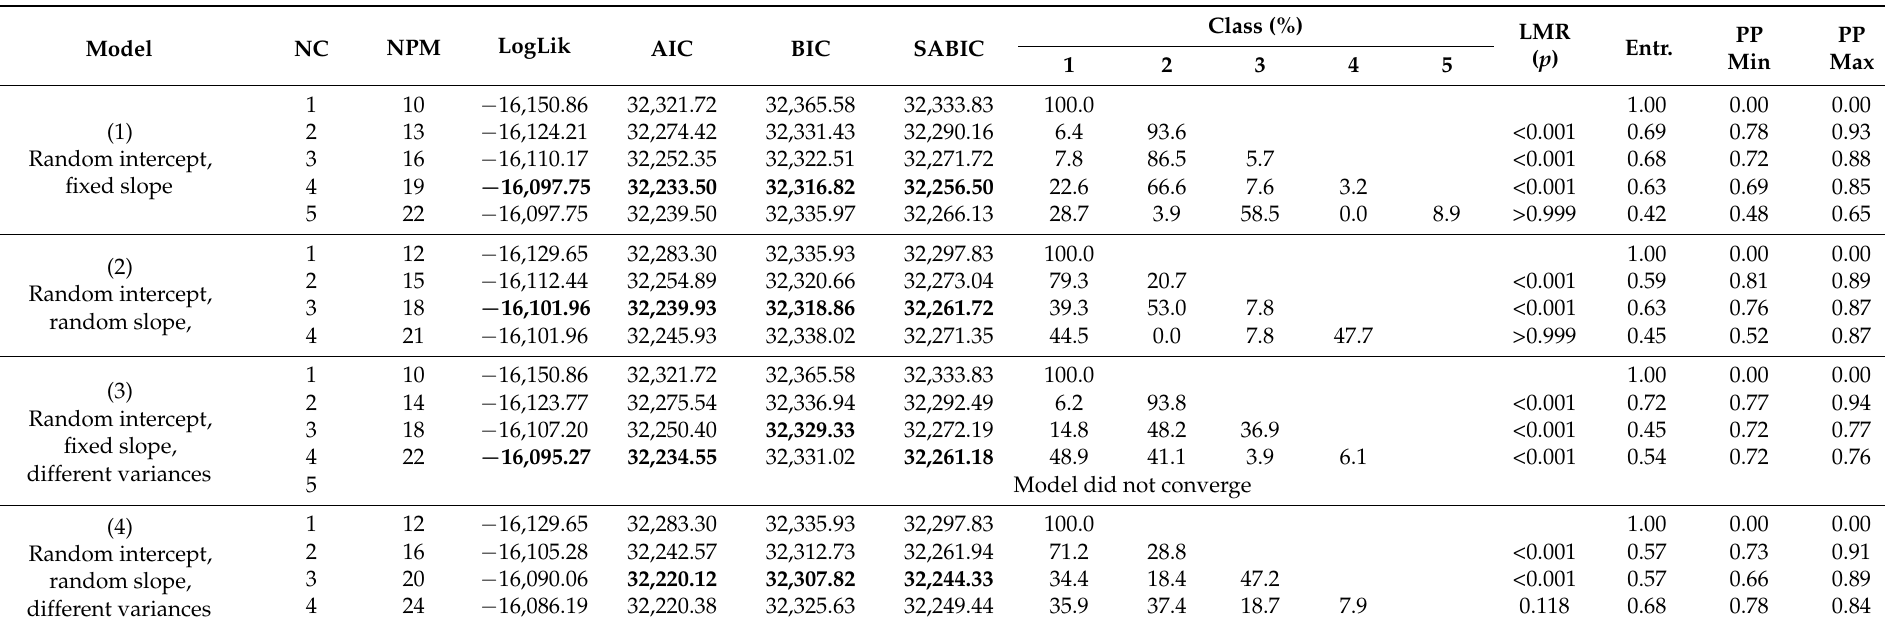
Table A7. Multivariate Latent Class Growth Analysis for QoLIBRI-OS and SF-12v2 MCS/PCS for participants with moderate or severe TBI (N =